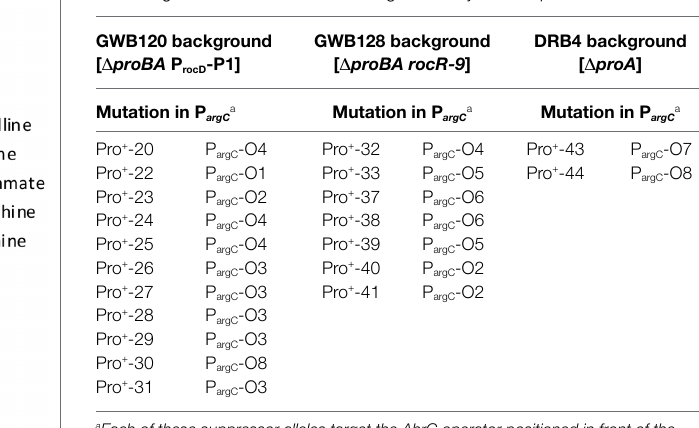
TABLE 3 | Suppressor mutations targeting the AhrC operator of the argCJBD- carAB-argF L-ornithine/L-citrulline/L-arginine biosynthetic